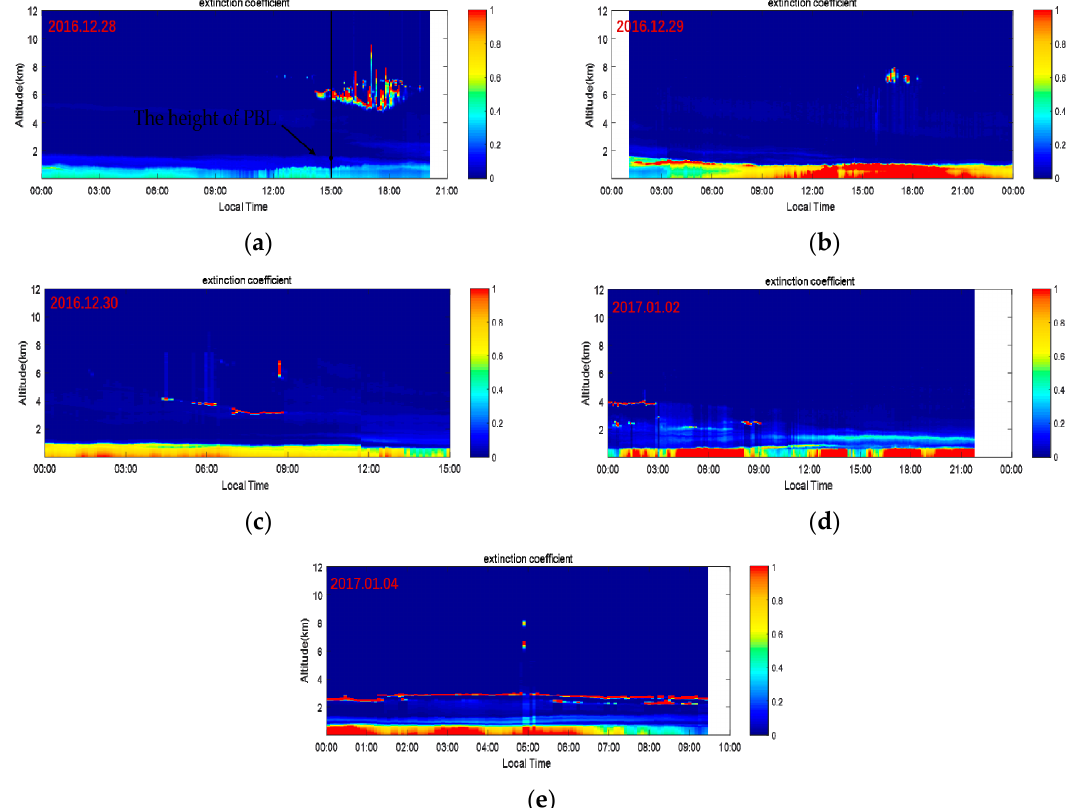
Figure 8. Vertical profile of particle extinction: ( a ) December 28 00:00–20:00; ( b ) December 29,